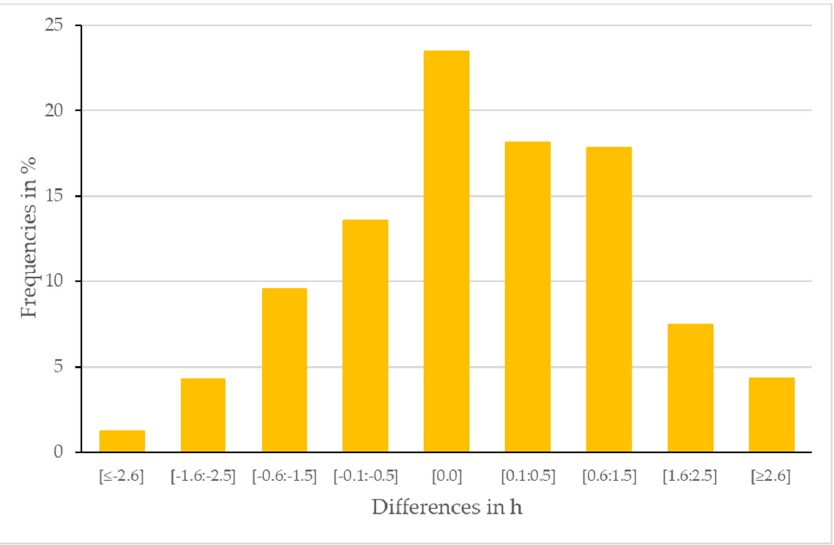
Figure 5. The distribution of differences in daily sunshine duration (automatic minus manual observations) in hours in Borucino, 2015–2021.